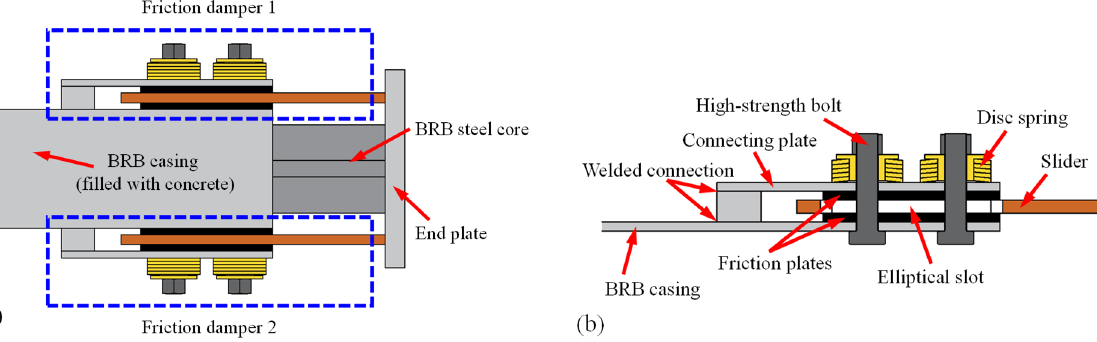
Figure 5. Construction details of FBRB: ( a ) connections between BRB and friction damper; and ( b ) details of the friction damper.